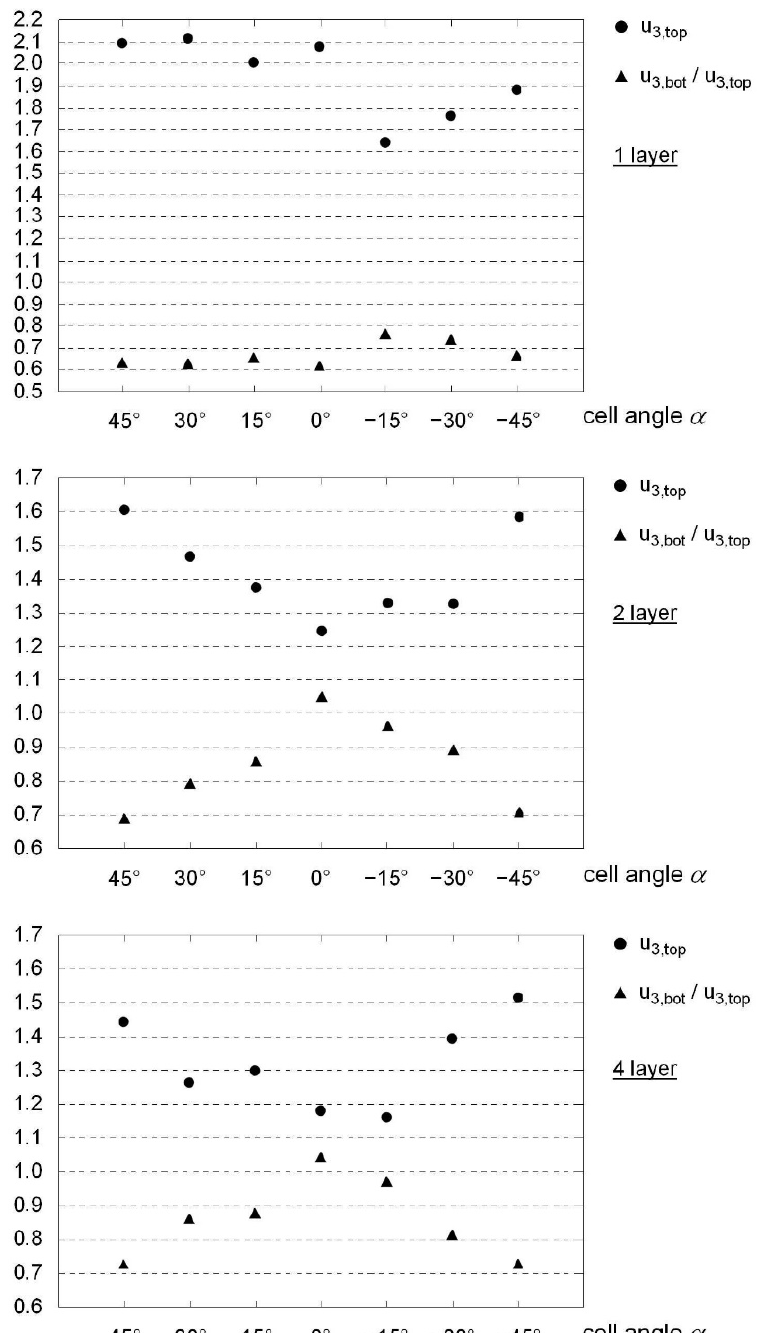
Figure 25. Three ‐ dimensional lattice cores: normalized maximum values for displacement 𝑢 (cid:2871),(cid:2930)(cid:2925)(cid:2926) Figure 25. Three-dimensional lattice cores: normalized maximum values for displacement u 3,top and and displacement ratio 𝑢 (cid:2871),(cid:2930)(cid:2925)(cid:2926) /𝑢 (cid:2871),(cid:2912)(cid:2925)(cid:2930) . displacement ratio u 3,top / u 3,bot